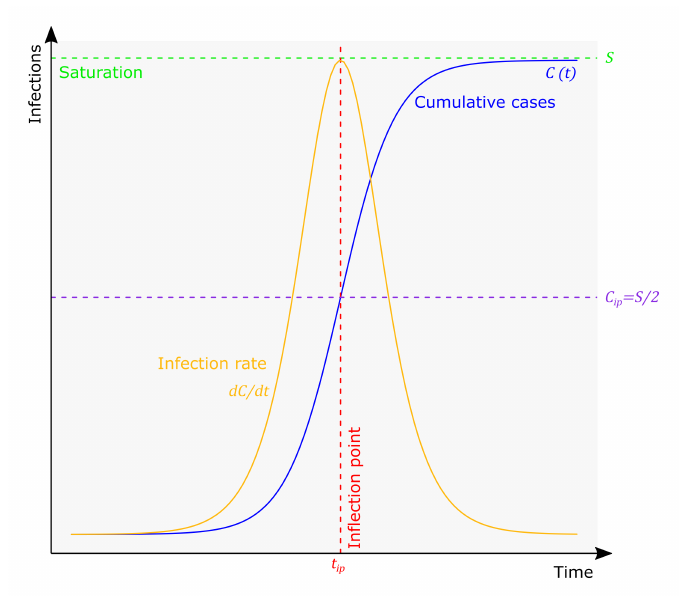
Figure 1: Logistic growth of an